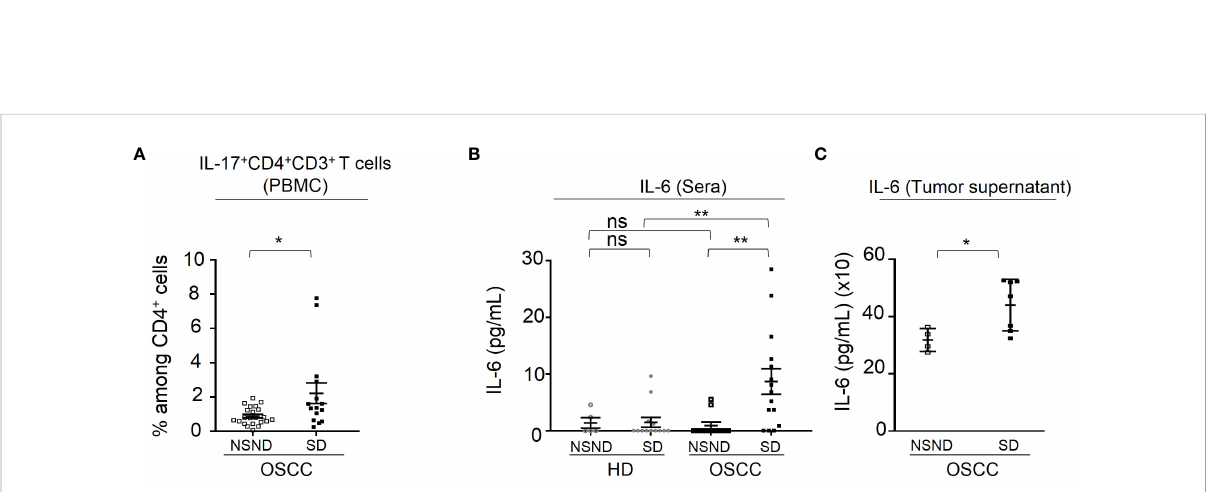
FIGURE 4 Analysis of IL-17 + CD4 + CD3 + T cells and of IL-6 production. (A) Percentage of IL-17 + blood cells detected in CD4 + CD3 + gated cells analyzed by fl ow-cytometry as described in Materials and Methods. Data are presented as percentages of cells among CD4 + T cells or by pg IL-6 per mL of serum or tumor supernatant. Data from 15 SD OSCC patients ( ■ ) were compared to those from 22 NSND OSCC patients ( □ ). (B) Detection of IL-6 in serums from 15 SD ( ■ ) and 11 NSND ( □ ) OSCC patients were compared to 5 NSND ( ○ ) and 13 SD ( ● ) healthy donors. (C) Detection of IL-6 in tumor supernatants from 7 SD ( ■ ) and 4 NSND ( □ ) OSCC patients. For statistical analysis, a Mann-Whitney test was used. Bars represent the standard error of the mean (SEM). *p ≤ 0.05; **p ≤ 0.01; ns: not signi fi cant.